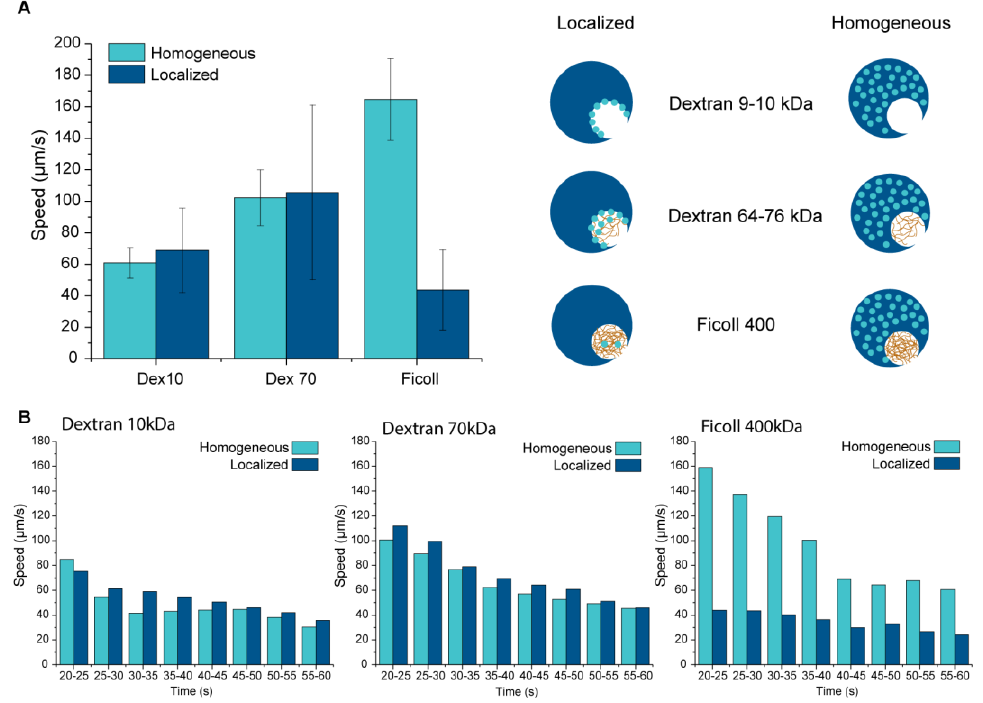
Figure 4. ( A ) The average speed over 10 s of the enzyme-localized systems compared to the previously obtained homogeneous systems [6] for all three polysaccharides at 4% hydrogen peroxide concentration. ( B ) The instantaneous speed of both systems was analysed over a time-course up to 60 s after addition at 4% hydrogen peroxide concentration.